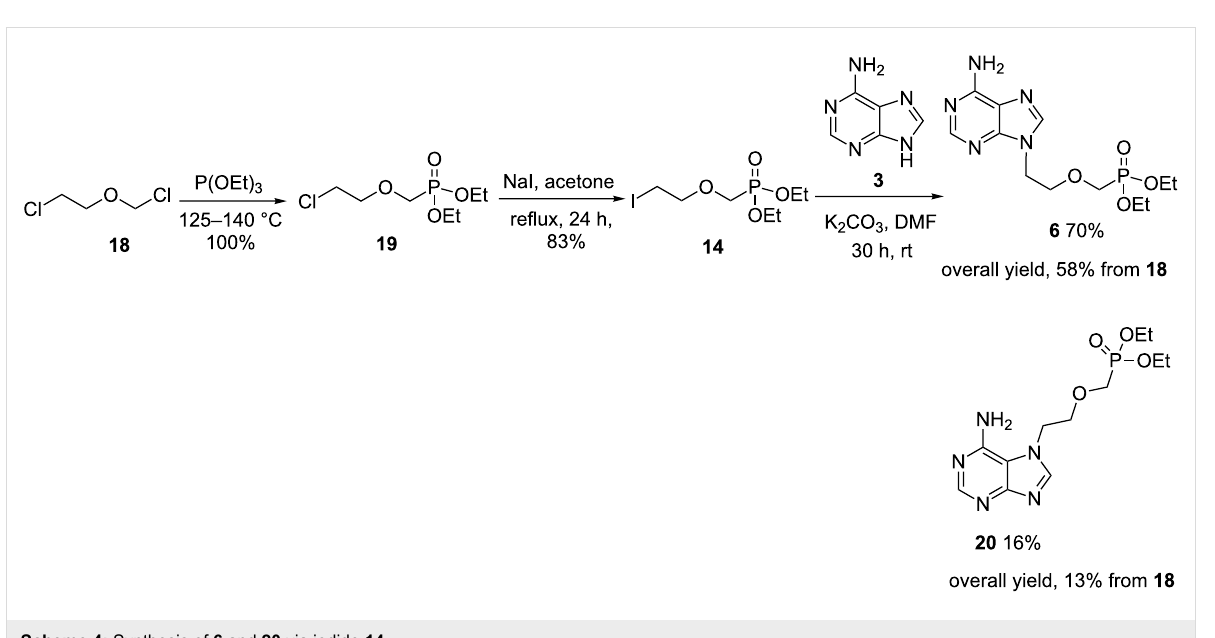
Table 2: Impact of base, solvent and temperature on reaction performance and regioselectivity.